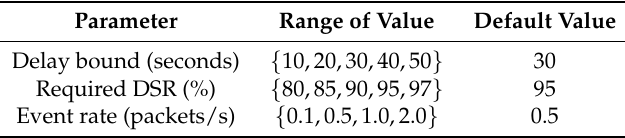
Table 4. Evaluation